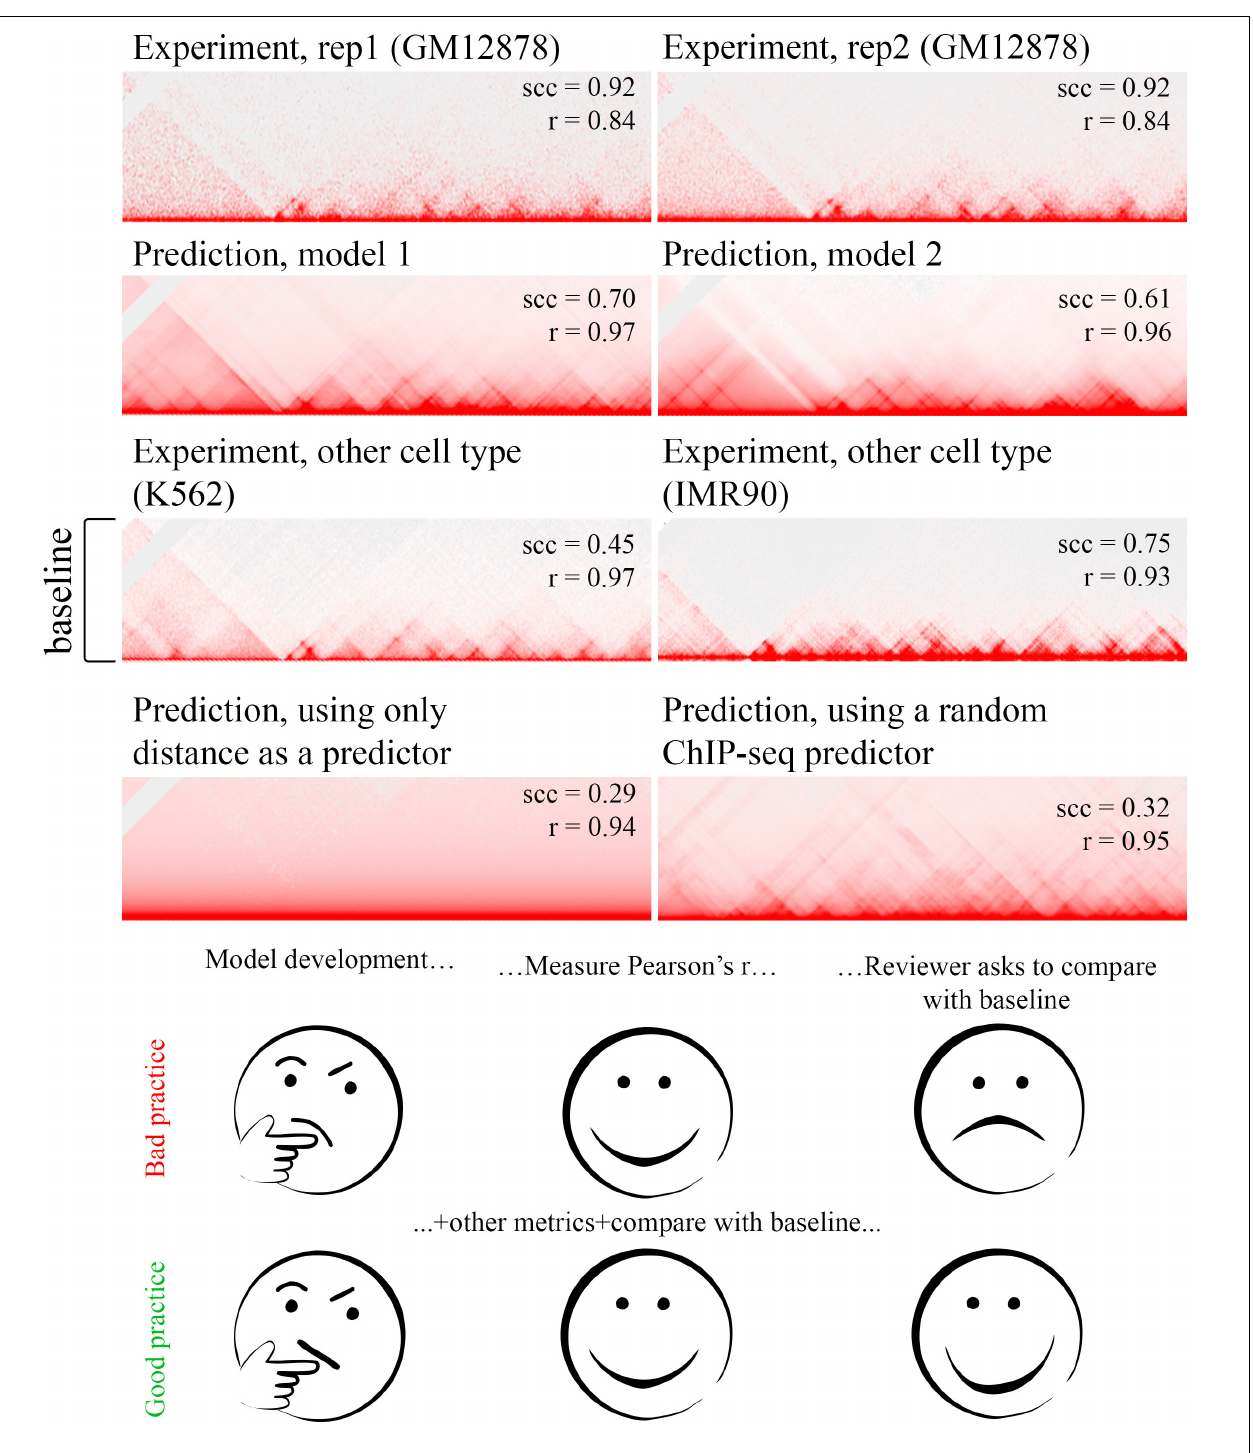
FIGURE 3 | The choice of the baseline plays a key role in assessing the prediction accuracy. Experimental data are from Rao et al. (2014); predictions generated using 3DPredictor (Belokopytova et al., 2020) supplemented with following data: genomic distance, CTCF, and RNA-seq (model 1); (Qi and Zhang, 2019) (model